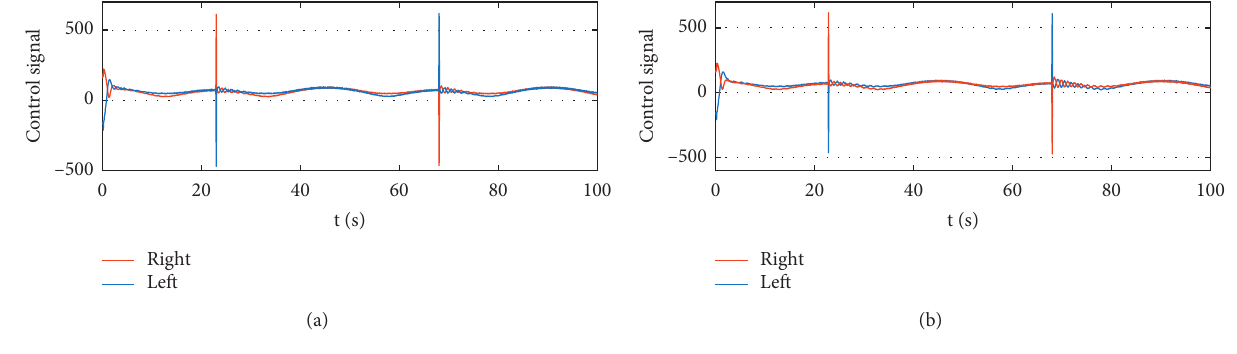
Figure 12: Control signals comparison. (a) FOPID and (b)